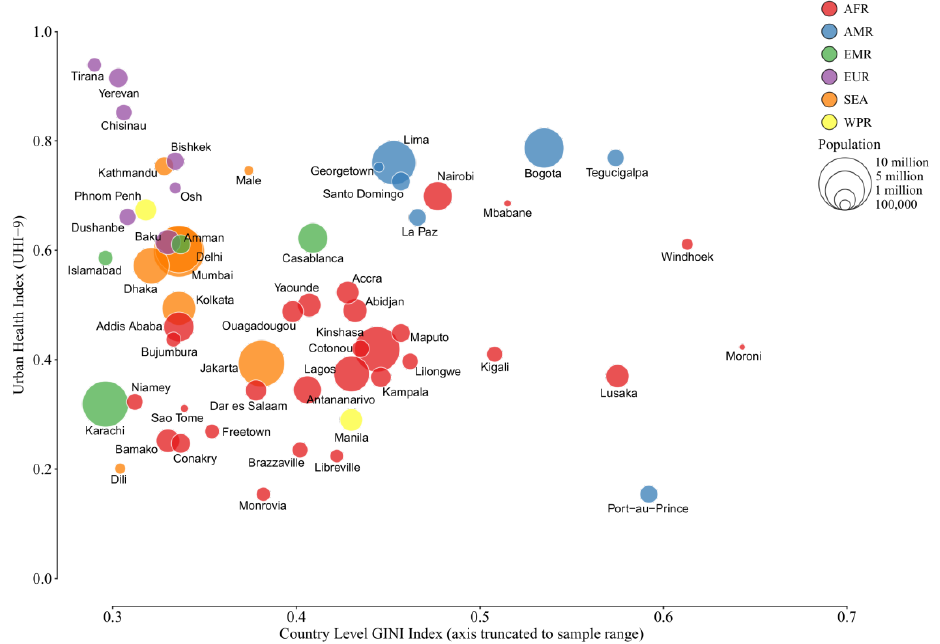
Figure 4. Relationship of UHI-9 and country-level index of income inequality (Gini Index). The graph contains four variables: the raw UHI-9 score for the city, country-level Gini Index, population size (represented by the size of the bubble), and WHO region (depicted by color).